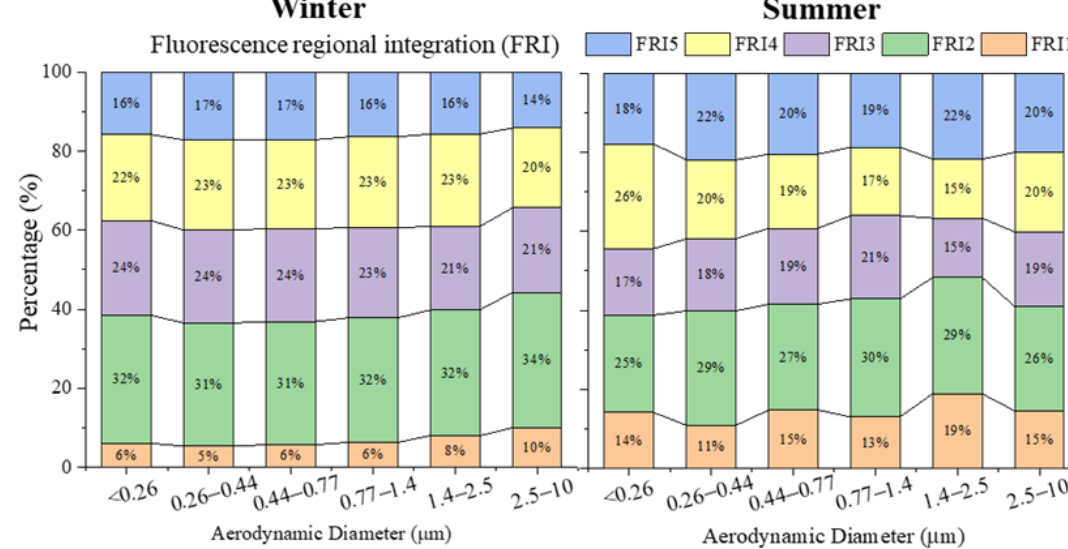
Figure 4. The size distribution of the fluorescence regional integration (FRI) for winter and summer. FRI1 to FRI5 are the FRI values of fluorescence regions I to V,